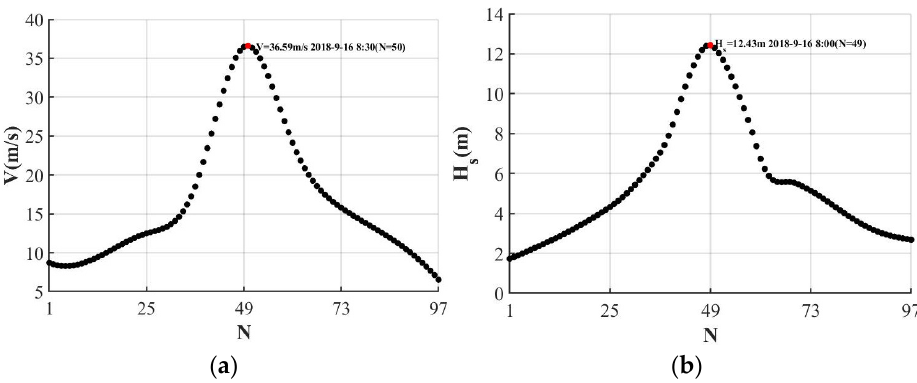
Figure 12. ( a ) Maximum wind speed and ( b ) Significant wave height at different stages: N = 1 corresponds to the data for 8:00 on 15 September.